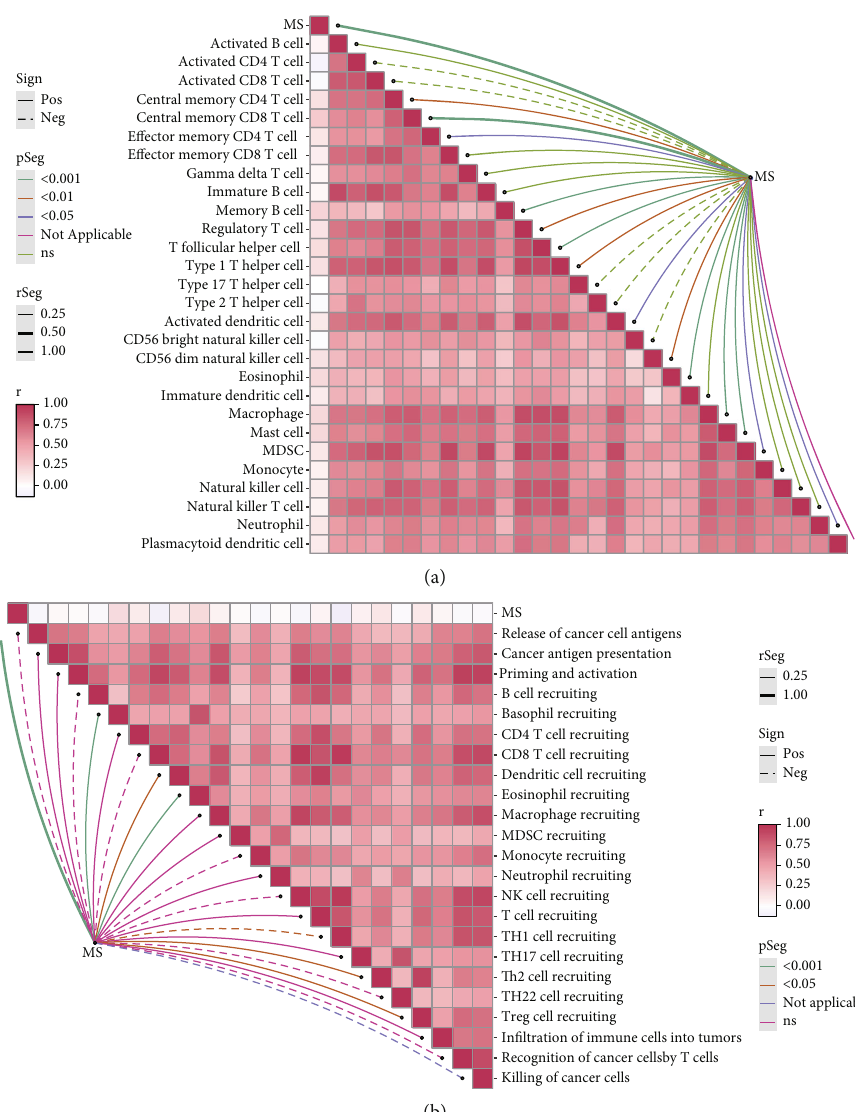
Figure 7: MS-related immunocyte in fi ltration. (a) Correlation between the immune cell content and MS. (b) Correlation between the cancer-immunity cycle and